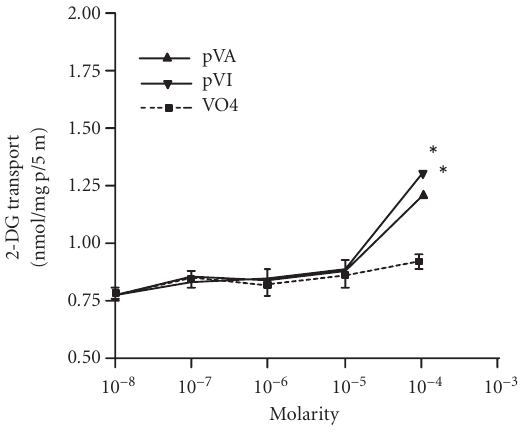
Figure 6. E ff ect of di ff erent vanadate compounds on 2-DG transport in L6 myotubes. Sodium orthovanadate ( --- ): no significant di ff erences were seen, P > . 05, 1-way ANOVA, F = 0 . 84, n = 3 (triplicate plates in all exper- iments). pVA ( (cid:1) — (cid:1) ): ∗ P < . 05, 1-way ANOVA, F = 7 . 3, n = 3